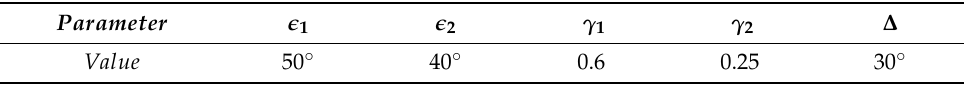
Table 5. Parameter values used in the